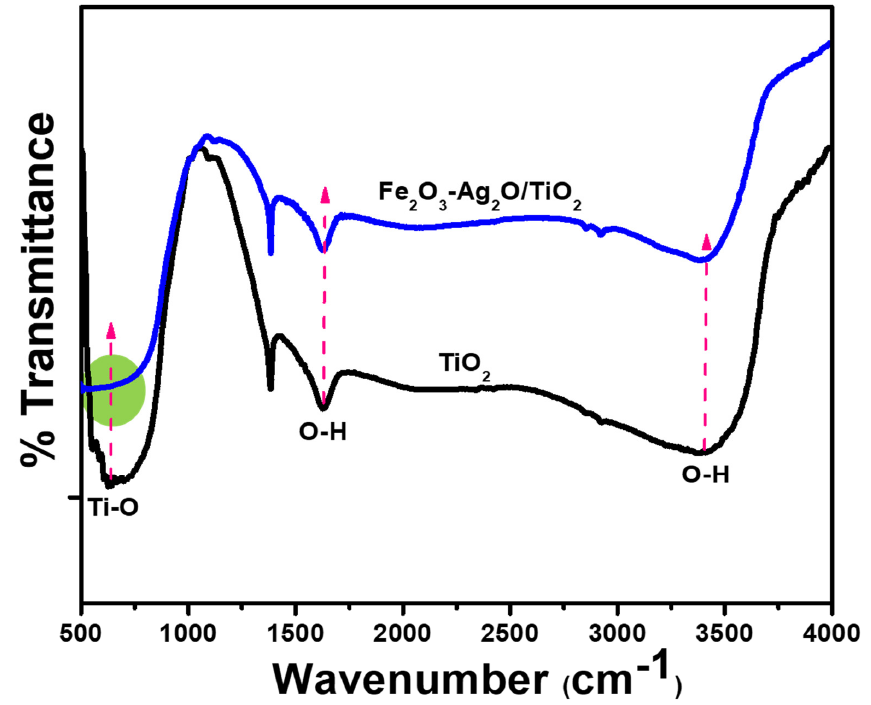
Figure 4. FTIR spectra of pure TiO 2 and Fe 2 O 3 -Ag 2 O/TiO 2 nanocatalyst.